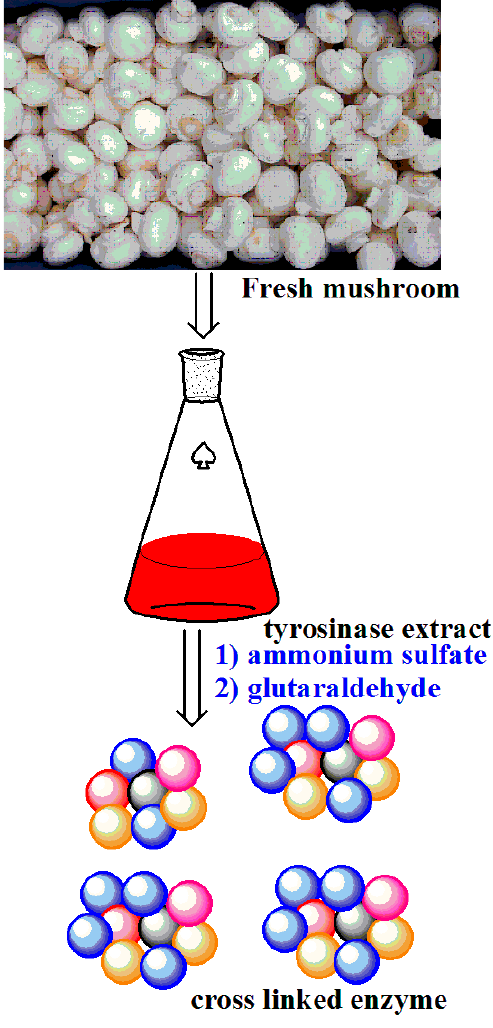
Figure 8. The steps involved in the synthesis of tyrosinase cross-linked enzyme aggregates for elimination of phenolic compounds from water [75].